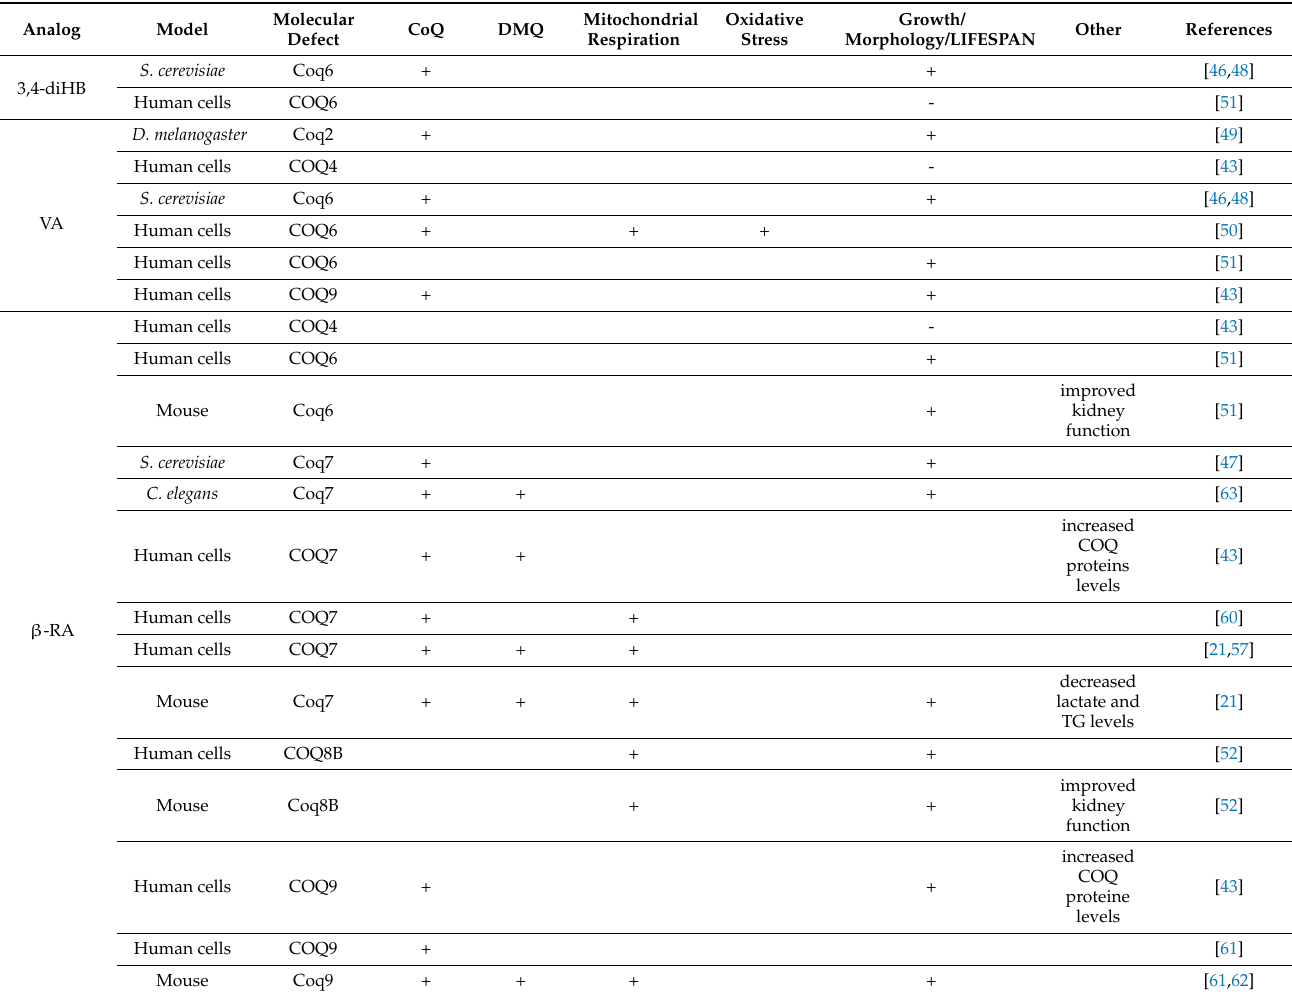
Table 1. Overview of published studies on the effects of supplementation with 4-HB analogs in the different models. Rescue/improvement is indicated by + and lack of effects by